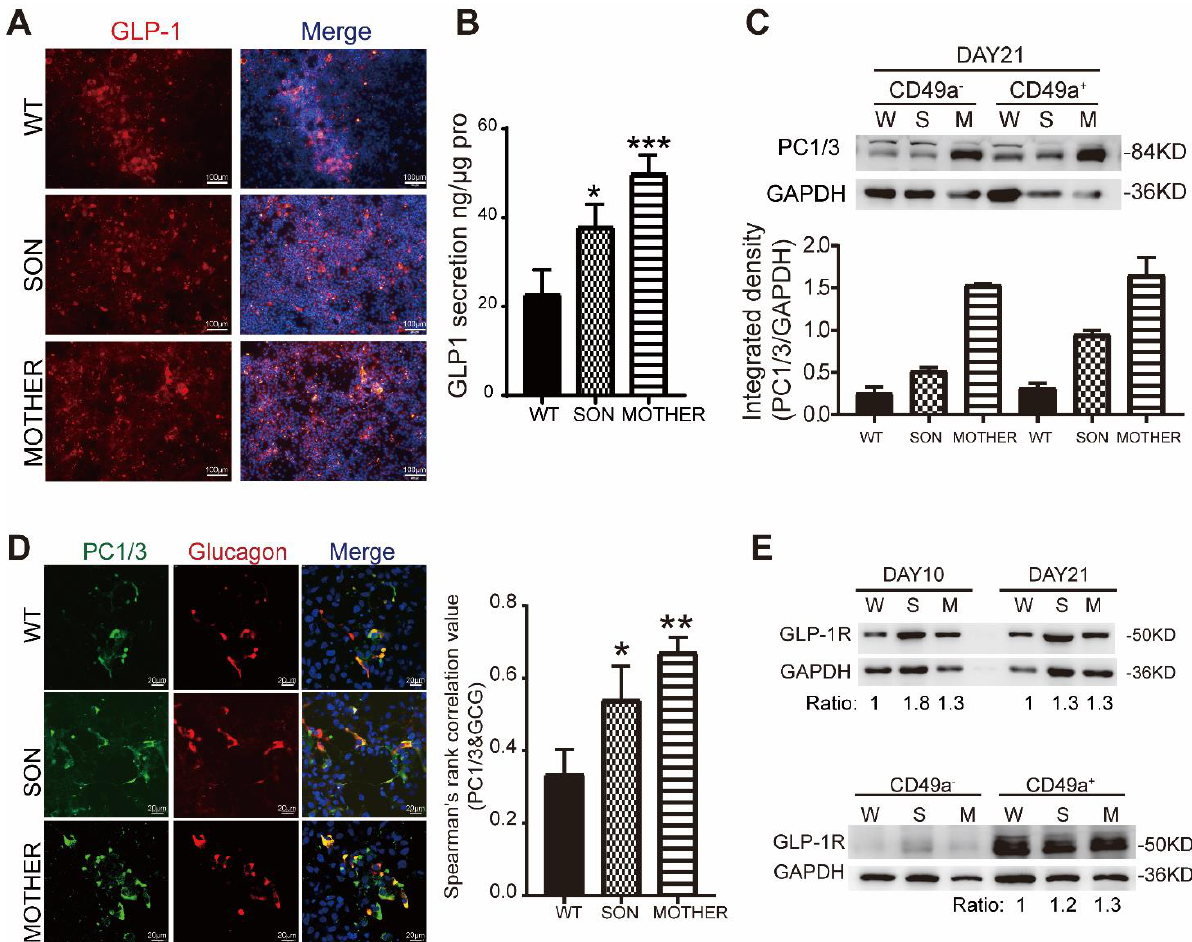
Figure 3. The secretion of GLP-1 rose in MEN1-derived cells with increased expression of GLP-1R depended on the high percentage of β -like cells. ( A ) The immunostaining of GLP-1 in IPC stage scale bar: 100μm . ( B ) ELISA measurement of GLP-1 secretion in IPC stage, n = 3. ( C ) The protein expression of PC1/3 in CD49a + and CD49a - IPCs, n = 5. ( D ) The immunostaining of PC1/3 and proglucagon in IPC stage and the correlative calculation by image J, n = 5, scale bar: 20μm . ( E ) The expression of GLP-1R in PPC and IPC stage and after cell-sorting with CD49a; the number below is representing the fold change after being normalized, n = 3; W-WT, S-SON, M-MOTHER. The bar plots ( n ≥ 3 wells per group) are the mean ± SEM. * p < 0.05, ** p < 0.01, and *** p < 0.001.